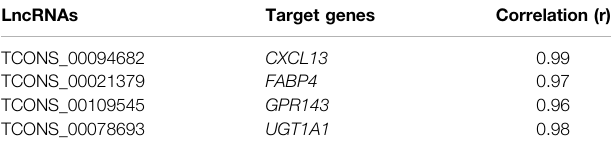
TABLE 2 | LncRNAs and target